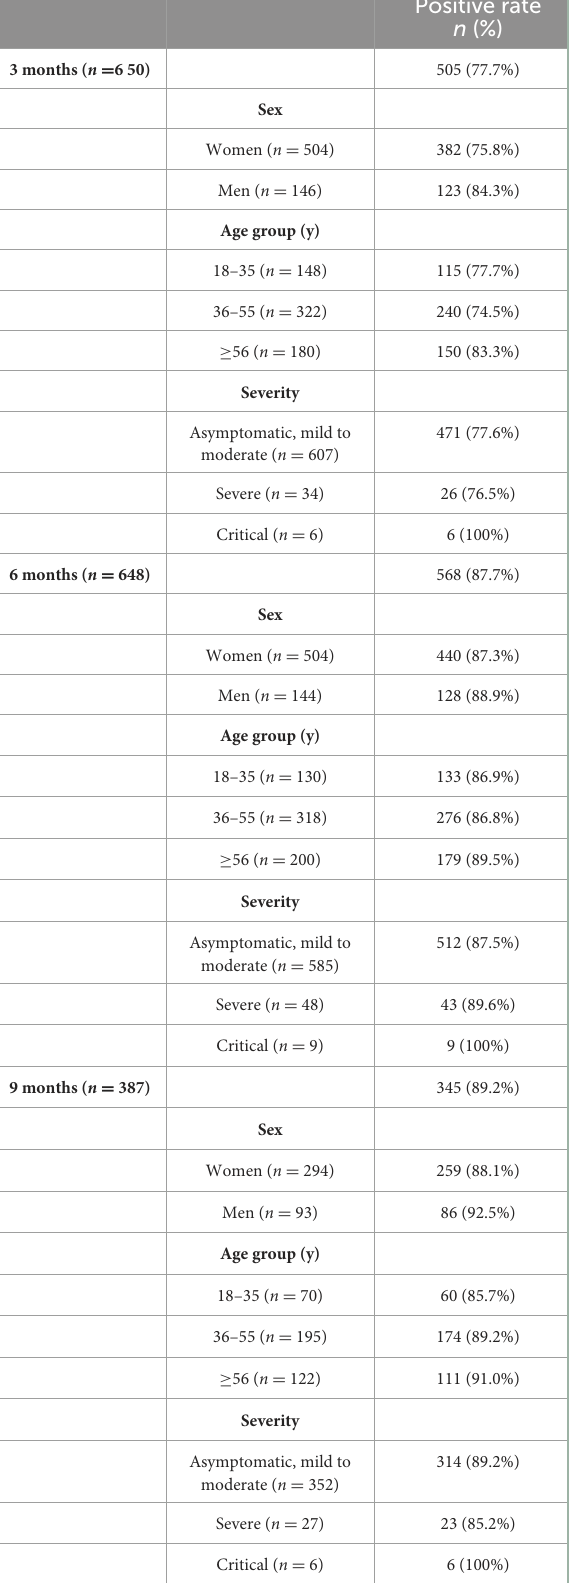
TABLE 4 Temporal changes in the positive rate for IgG antibodies.